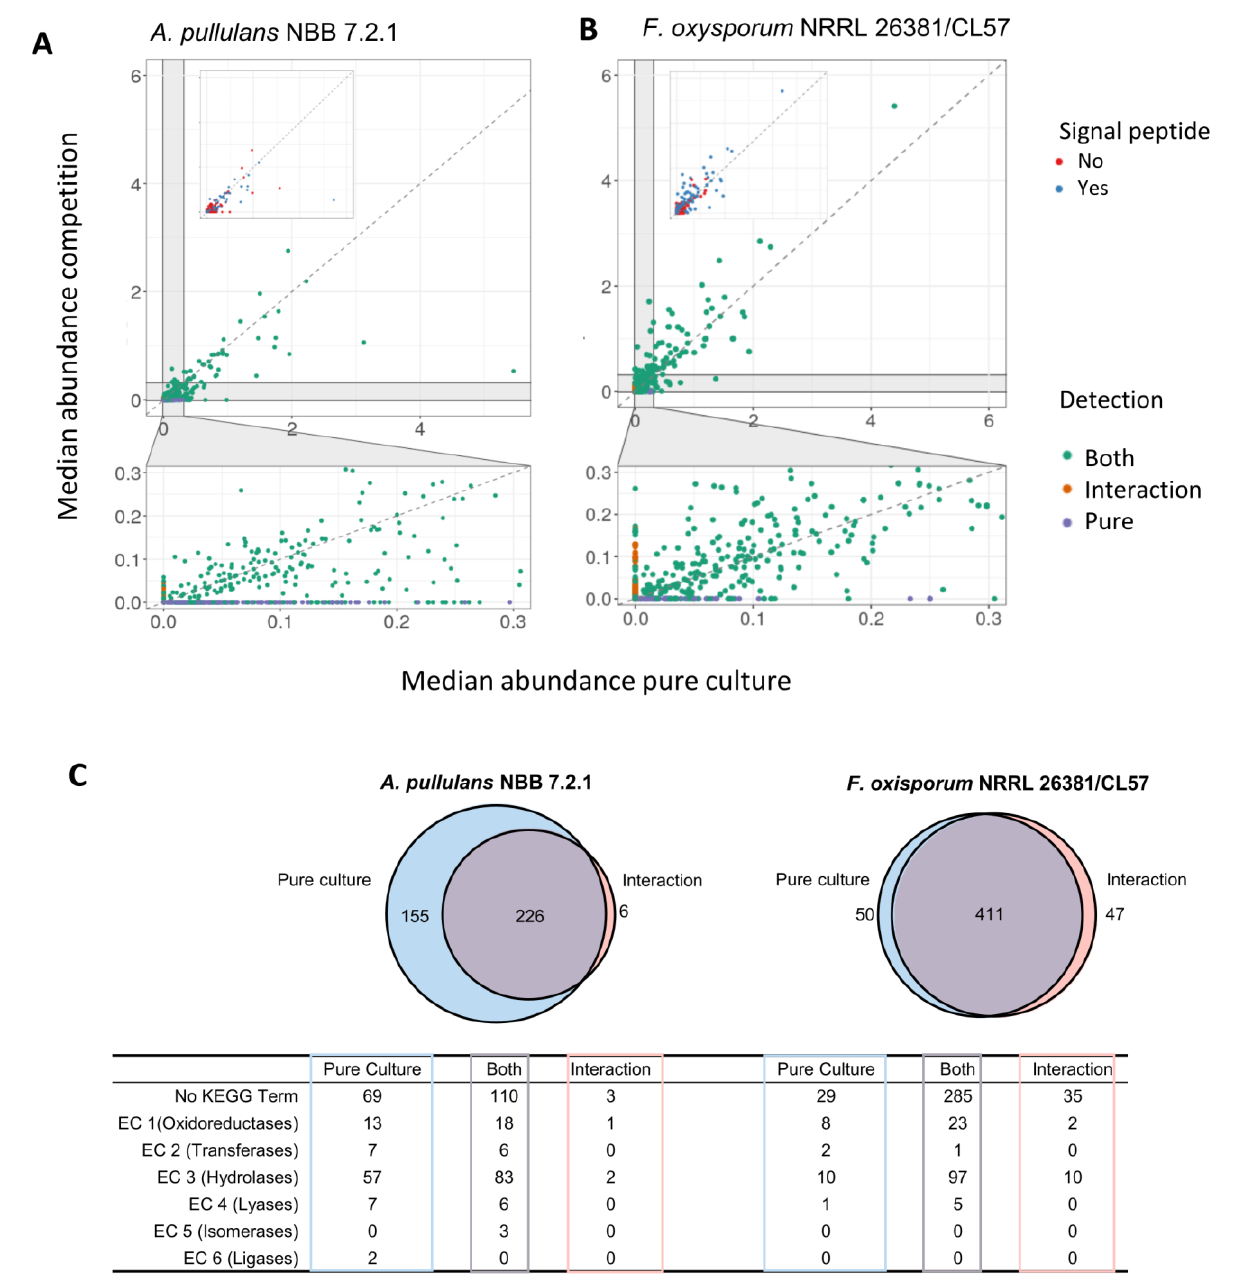
FIGURE 7: Secretome analysis of A. pullulans NBB 7.2.1 and F. oxysporum NRRL 26381/CL57 pure cultures and a co-culture. Supernatant from pure and co-cultures of A. pullulans NBB 7.2.1 and F. oxysporum NRRL 26381/CL57 were filtered with a 0.2 µm membrane and concen- trated with > 50 kDa ultrafiltration tubes. These extracts of secreted proteins were analysed with a proteomics pipeline. Median abundance of all proteins detected in pure culture (x-axis) and during the competition (y-axis) for A. pullulans NBB 7.2.1 (A) and F. oxysporum NRRL 26381/CL57 (B) . In the upper panel insert, proteins with or without a predicted signal peptide are highlighted in blue and orange color, re- spectively. The lower panel shows proteins of low abundance and highlights those only detected during the competition (orange) or in pure culture (blue). (C) For A. pullulans NBB 7.2.1, only few proteins were uniquely found during the competition with F. oxysporum NRRL 26381/CL57, while for F. oxysporum NRRL 26381/CL57 almost equal numbers of unique proteins were detected in the pure culture and the competition. KEGG term annotation of the proteins in the different categories is